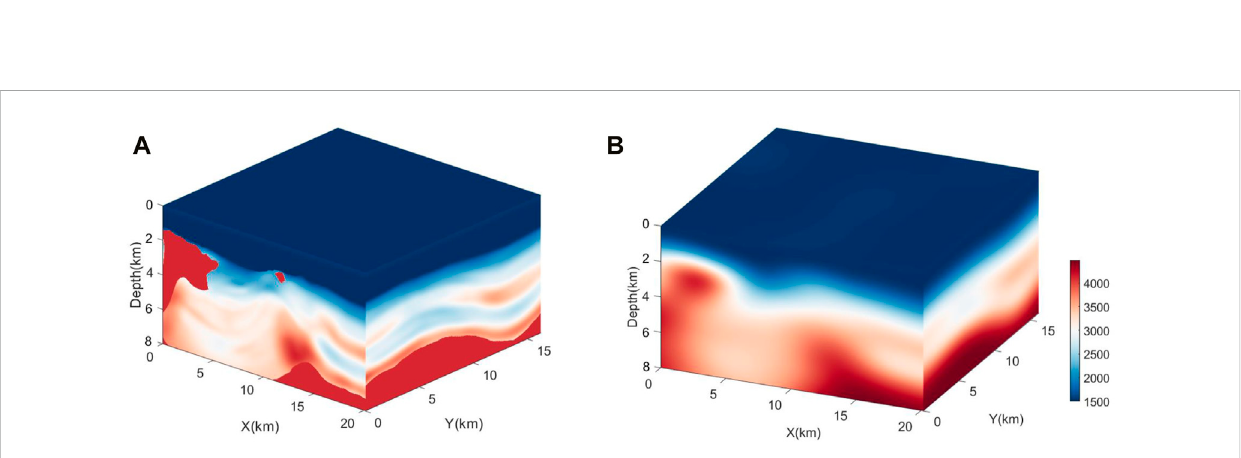
FIGURE 9 (A) Velocity model acquired from tomography, in which the salt body is well demonstrated, whereas some detailed structures are yet to be recovered. (B) Initial model for 3D FWI.